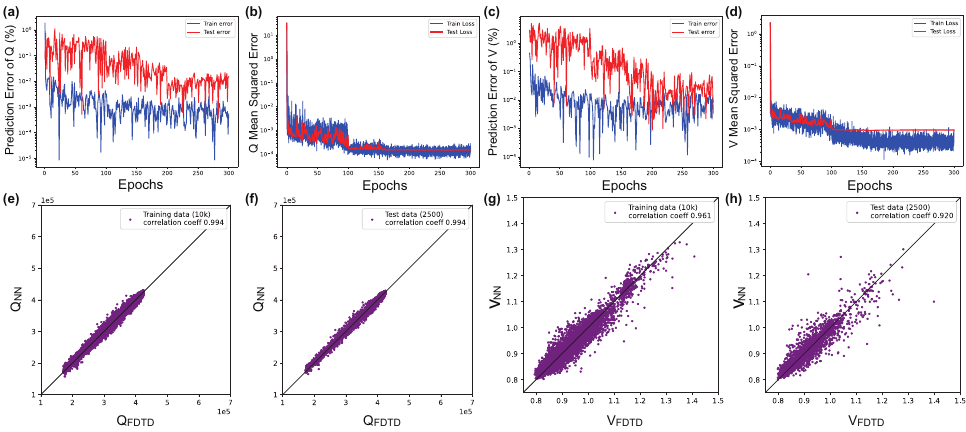
Figure 4. Learning curves and training results for POViT when GELU is used as the activation function. The four plots on the left ( a , b , e , f ) are for Q , while the four on the right ( c , d , g , h ) are for V . To compare the performances of different models (CNN, MLP, POViT (ours), CvT) on the photonic characterization task, open-source code for CNN are downloaded from Li et al. [8] and augmented by us as stated above while results for MLP are followed directly from Li et al. [8] without modifications. Reproduced results for CNN are plotted in Figures S3 and S4 in the Supplementary Materials and original results for CvT